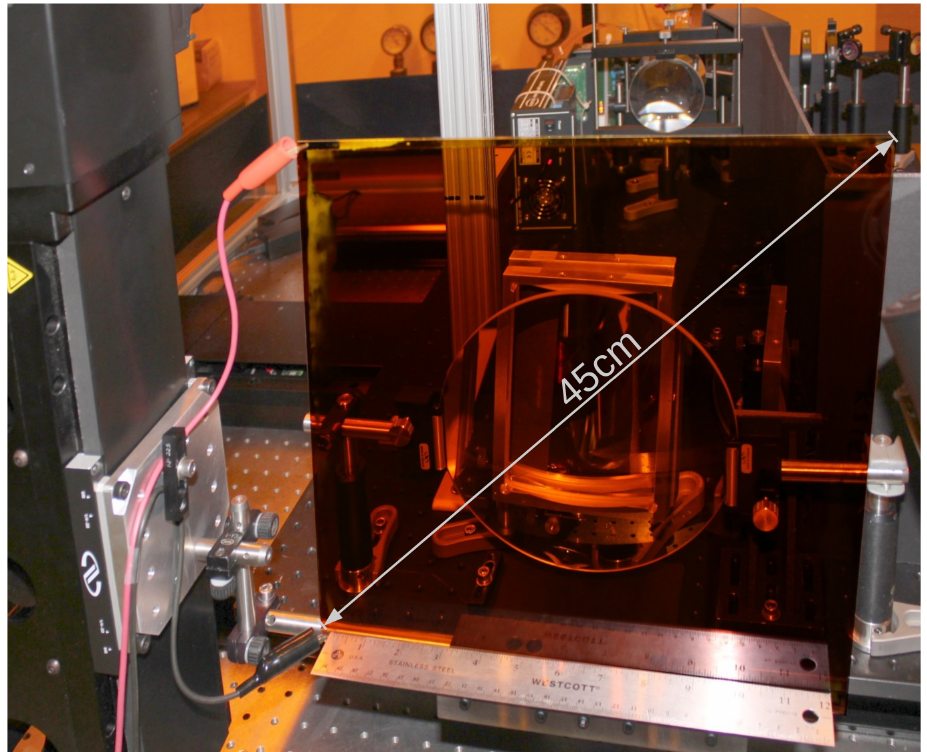
Figure 6. Picture of a large 45-cm diagonal photorefractive screen in front of the optical setup used to record the holograms. The sample is composed of a 100 µ m layer of photorefractive polymer sandwiched between two glass plates; the inner sides of the glass plate are coated with indium tin oxide (ITO) transparent electrode. The red and black cables attached to the sample are providing the voltage for the external electric